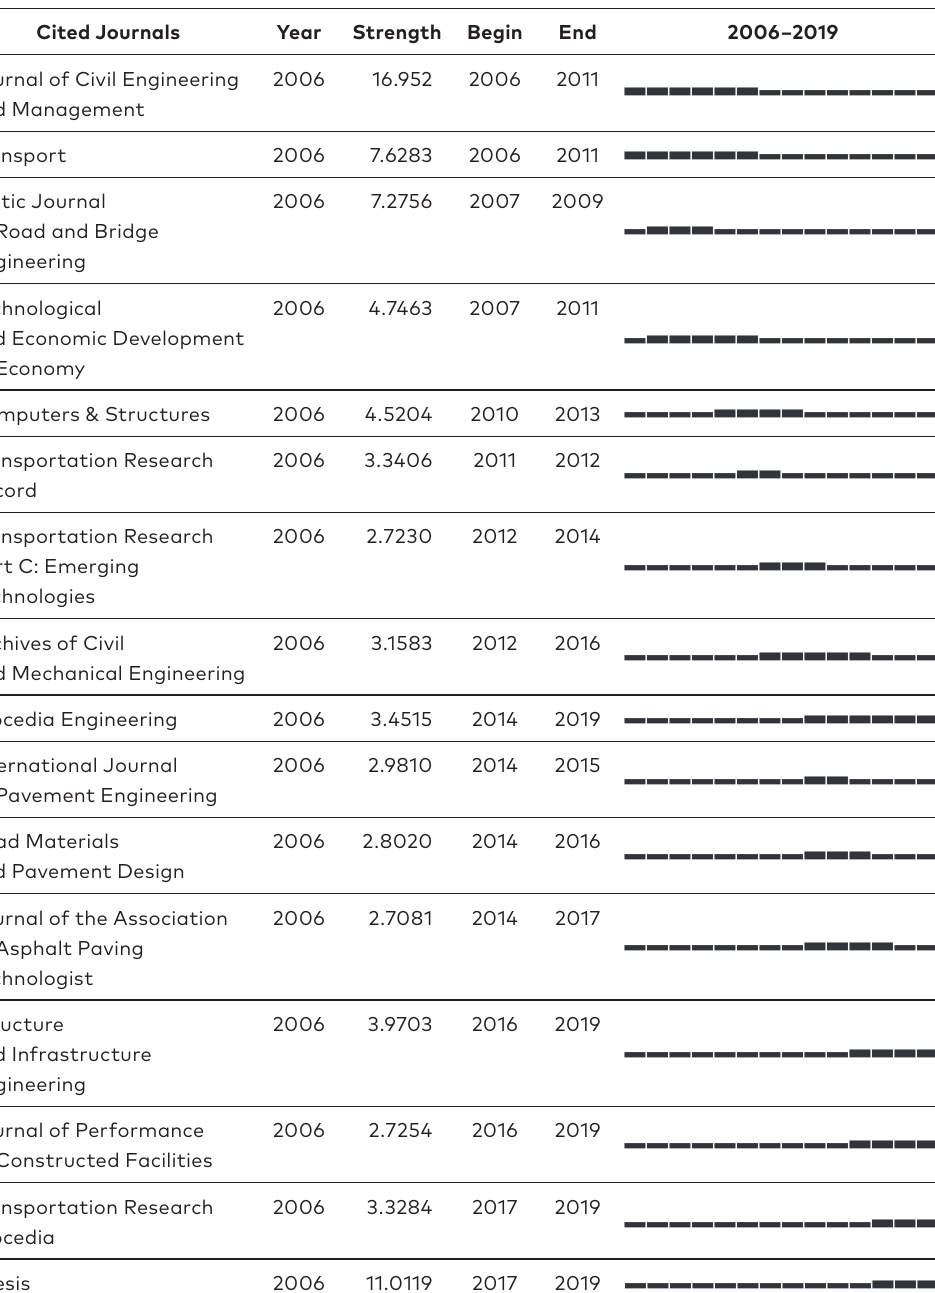
Table 9. Top sixteen cited journals with the strongest citation bursts